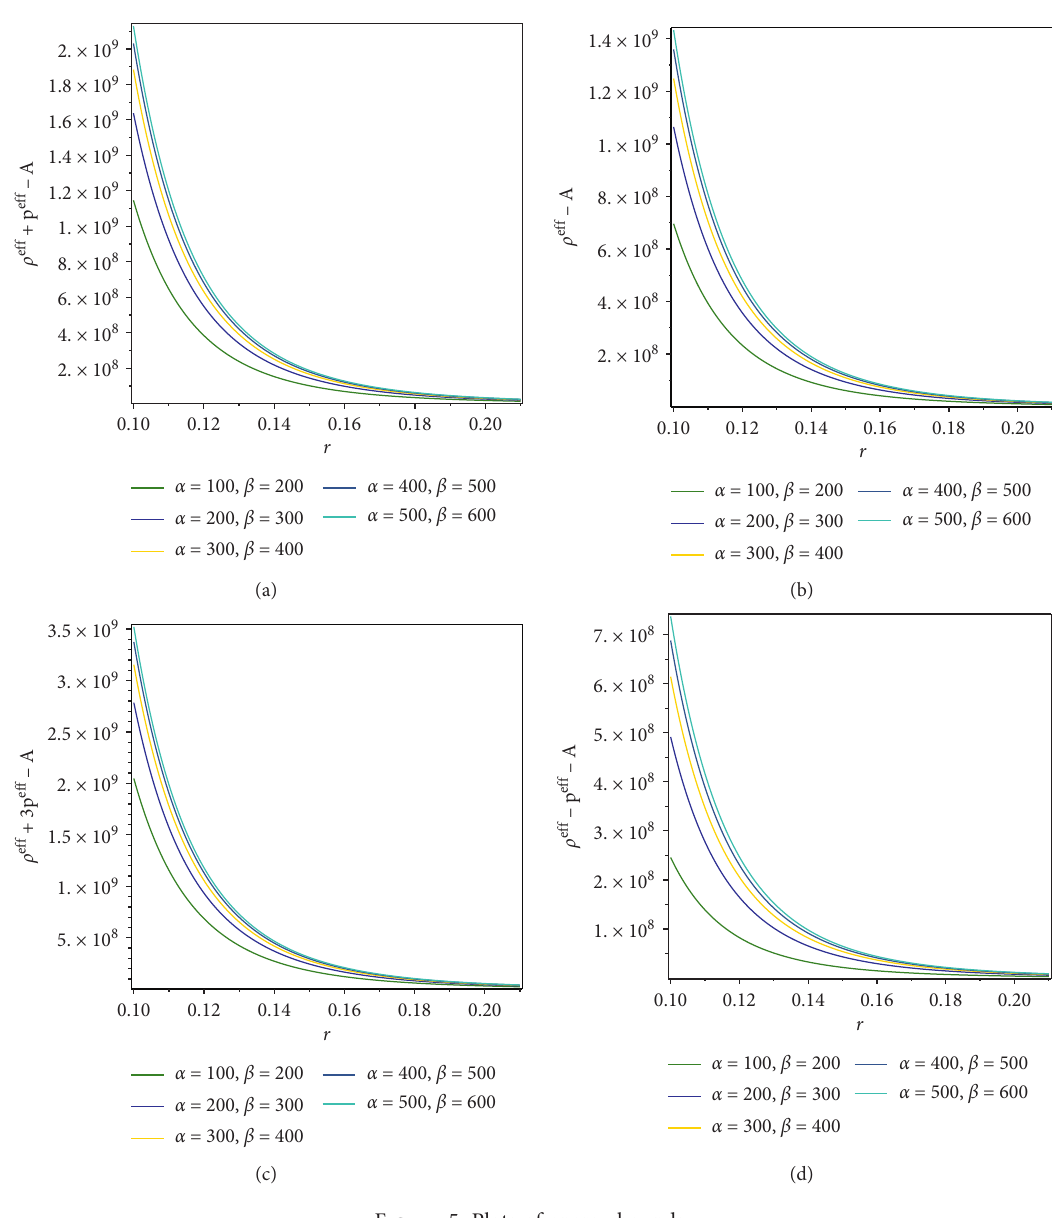
Figure 5: Plots of energy